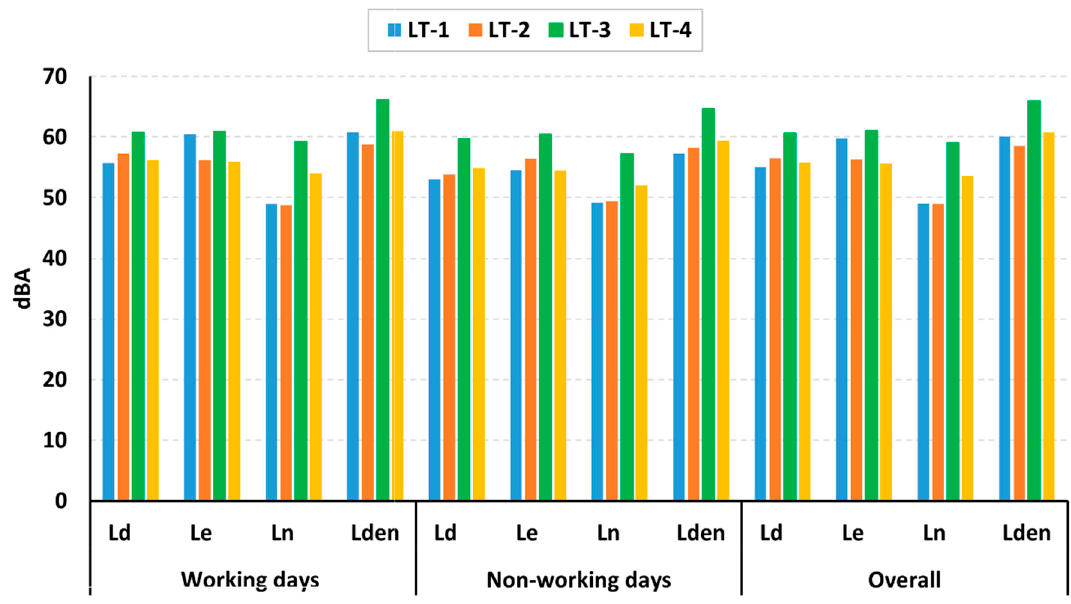
Figure 3. Values for L d , L e , L n and L den sound indicators at points LT-1 to LT-4 in the University Hospital of Badajoz.